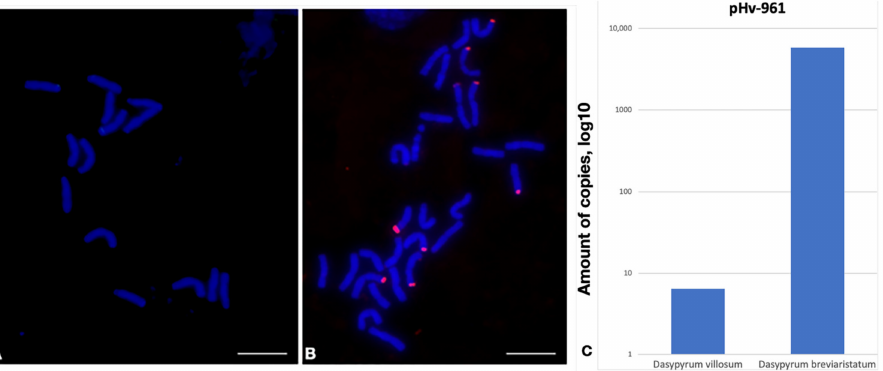
Figure 2. Localization of pHv-961 tandem repeat on the metaphase chromosomes of ( A ) Dasypyrum villosum PI 21717 and ( B ) Dasypyrum breviaristatum PI 516547 using fluorescence in situ hybridization. Red signals indicate the chromosomal localization of the pHv-961 tandem repeat. The bar indicates 10 µ m. ( C ) Histogram of the copy number of the tandem repeat pHv-961 in Dasypyrum villosum PI 21717 and Dasypyrum breviaristatum PI